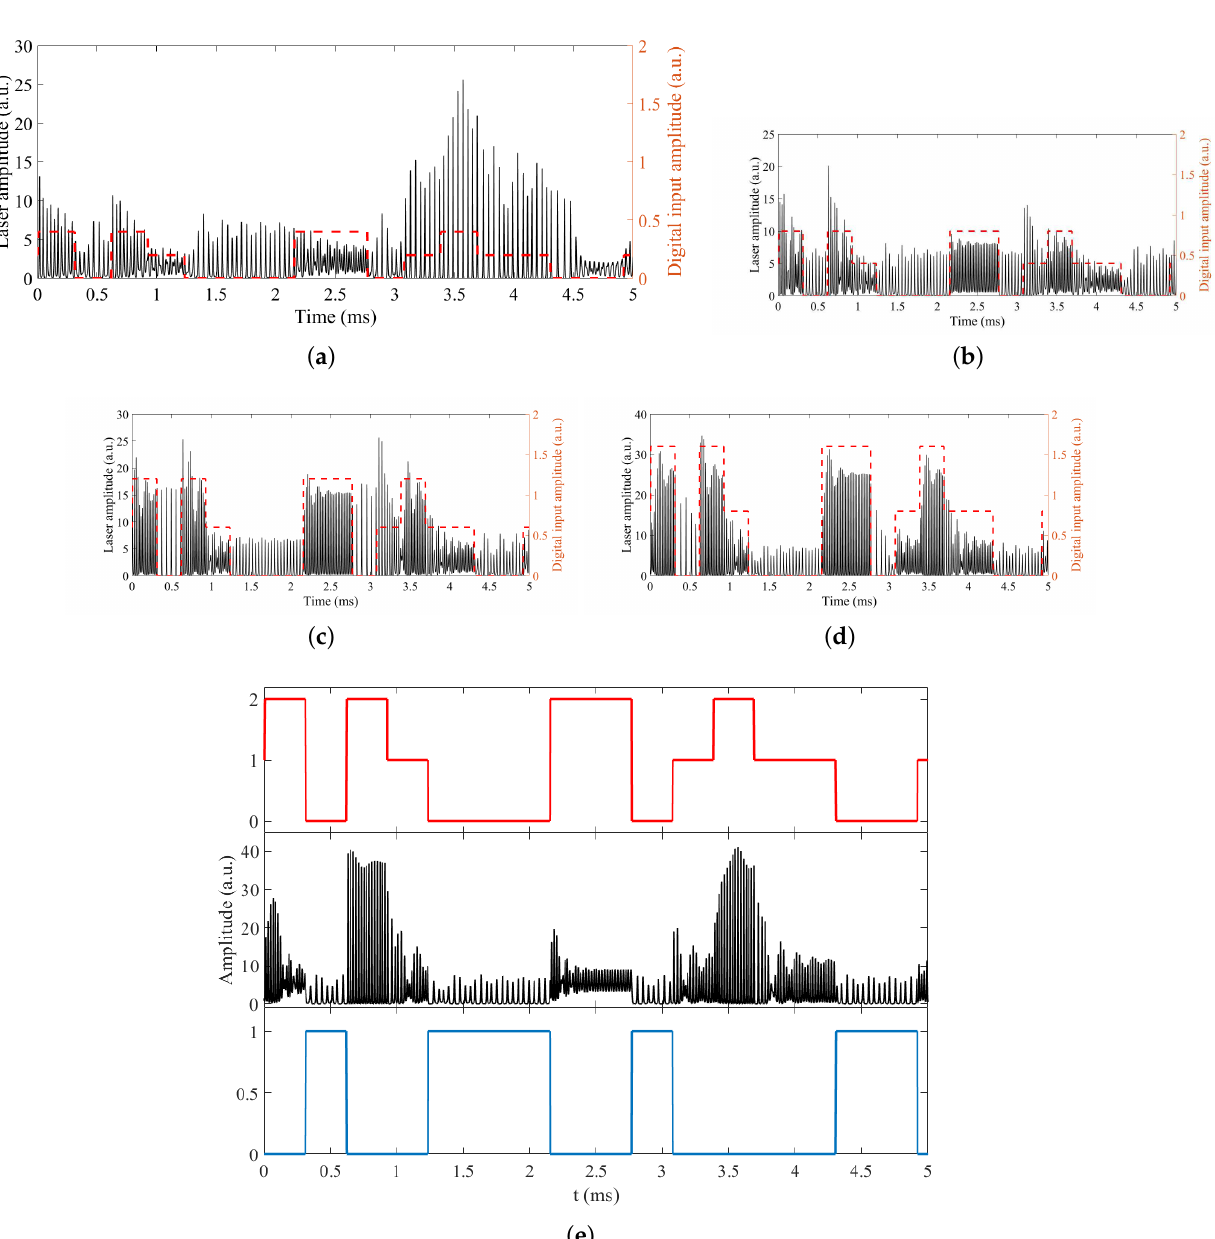
Figure 5. ( a – d ) Behavior of laser intensity (solid black line) when adding a digital signal (red line) of amplitude ( a ) 0.2 V, ( b ) 0.4 V, ( c ) 0.6 V, ( d ) 0.8 V. ( e ) (black line) EDFL behavior for a digital amplitude of 1 V. (red line) Digital input signal I d , (blue line) output of logic gate determined when P 2 is taken as logical 1 and response in P 1 is taken as a logical